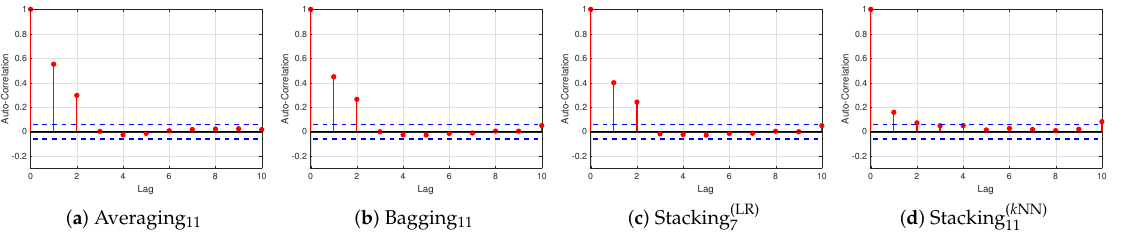
Figure 9. Autocorrelation of residuals for XRP dataset of ensemble models using CNN-BiLSTM as base